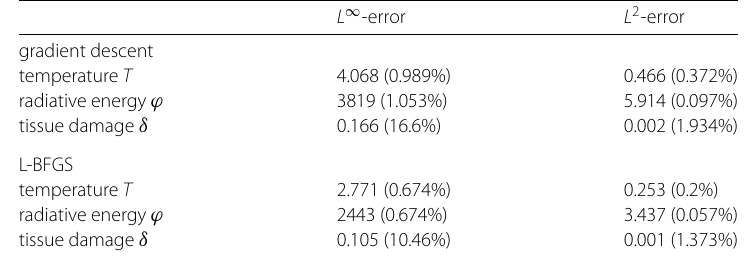
Table 3 Comparison between the simulated and measured temperature for multiple